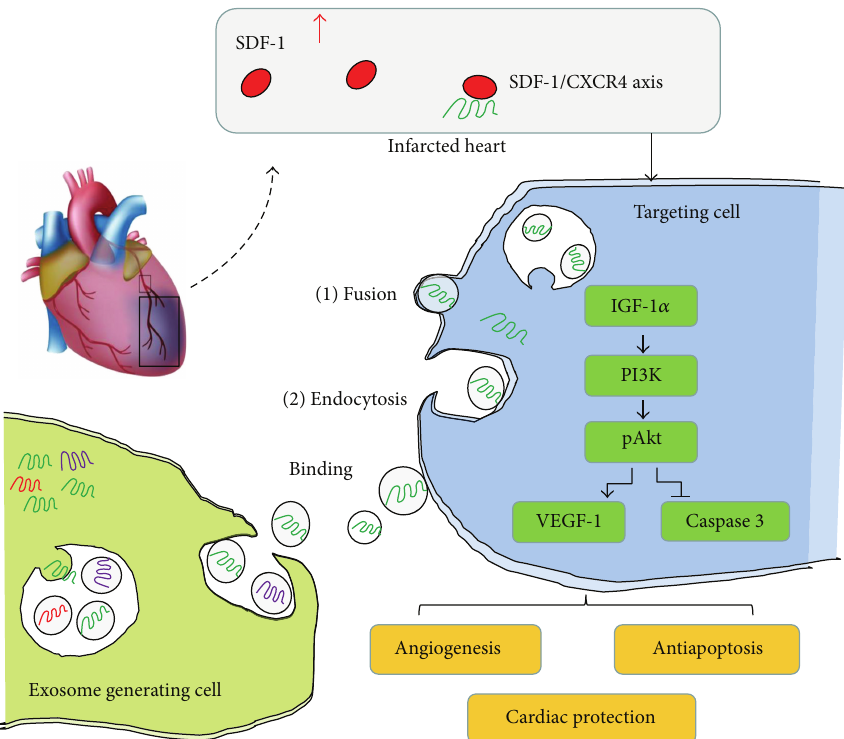
Figure 8: Schematic depiction of functional exosomes secreted from MSC overexpressing CXCR4 for activation of signaling pathways for restoration of LV function after MI. In exosome generating cells, CXCR4 are selectively incorporated into the intraluminal vesicles (IVLs) of multivesicular endosomes (MVEs) from the plasma membrane. Then, by fusing with the plasma membrane, MVEs release CXCR4- enriched exosome into the extracellular milieu. CXCR4-enriched exosomes can bind to the plasma membrane of the targeting cells. These recruited CXCR4-enriched exosomes may either fuse directly with the plasma membrane or fuse with delimiting membrane of an endocytic compartment. Then, released CXCR4 can be delivered into the membrane or cytosol of the targeting cell which contributes to SDF-1 𝛼 /CXCR4 interaction. In infarcted heart tissue, increased binding of SDF-1 𝛼 to CXCR4 activates G-protein-coupled receptor kinases, which activate a cascade of signaling pathways in cells. Pretreatment of stem/progenitor cells with CXCR4-enriched exosome can reduce MI-induced cell death and promote angiogenesis through PI3K/Akt signaling pathway activation, thereby enhancing heart function